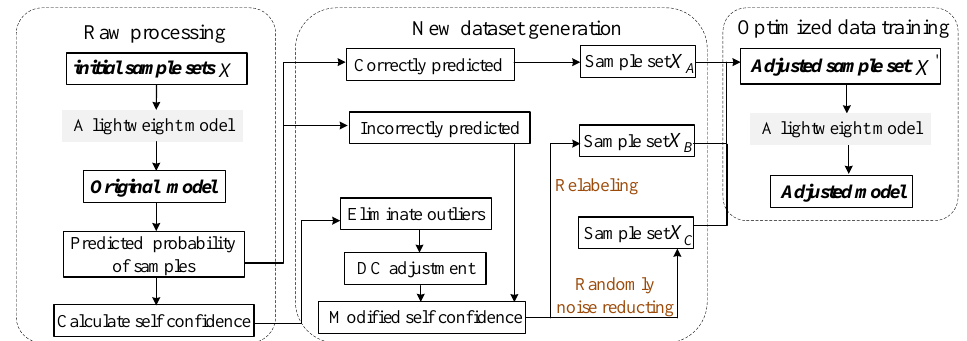
Figure 3. Application